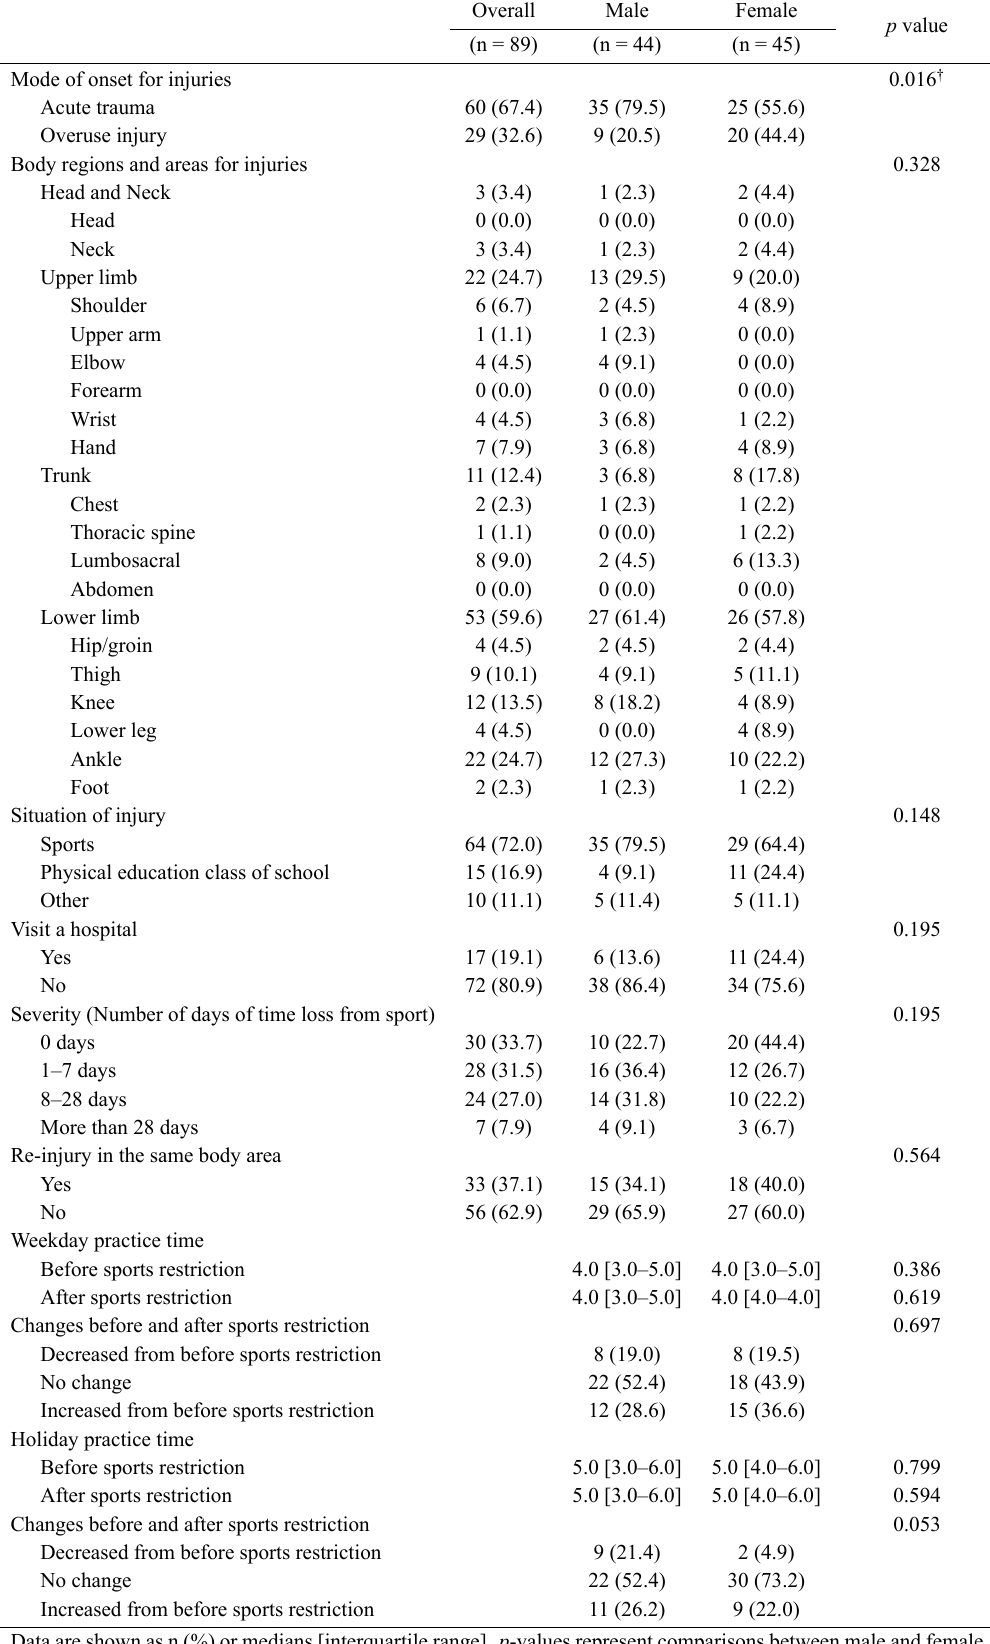
Table 3. Gender differences in injury